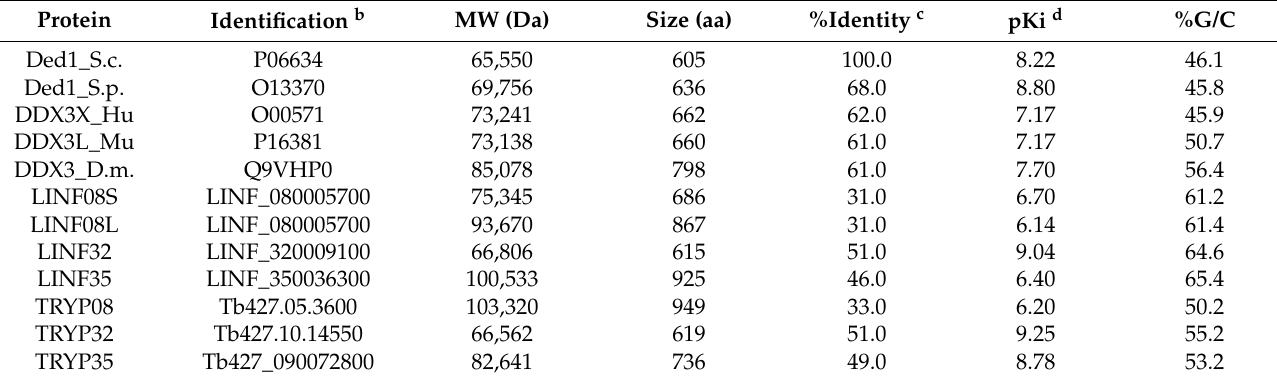
Table 1. Properties of selected DDX3-like genes and expressed proteins a